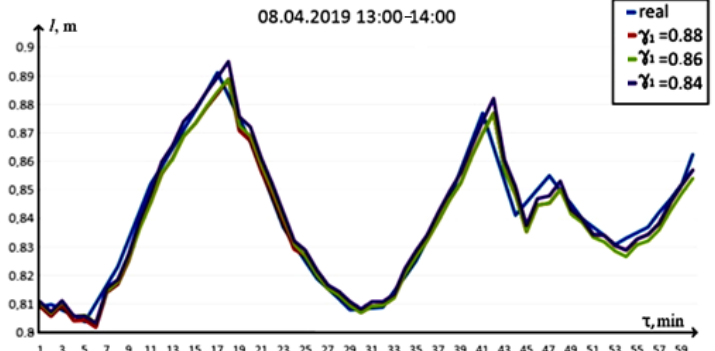
Figure 4. Predicting the torch length.